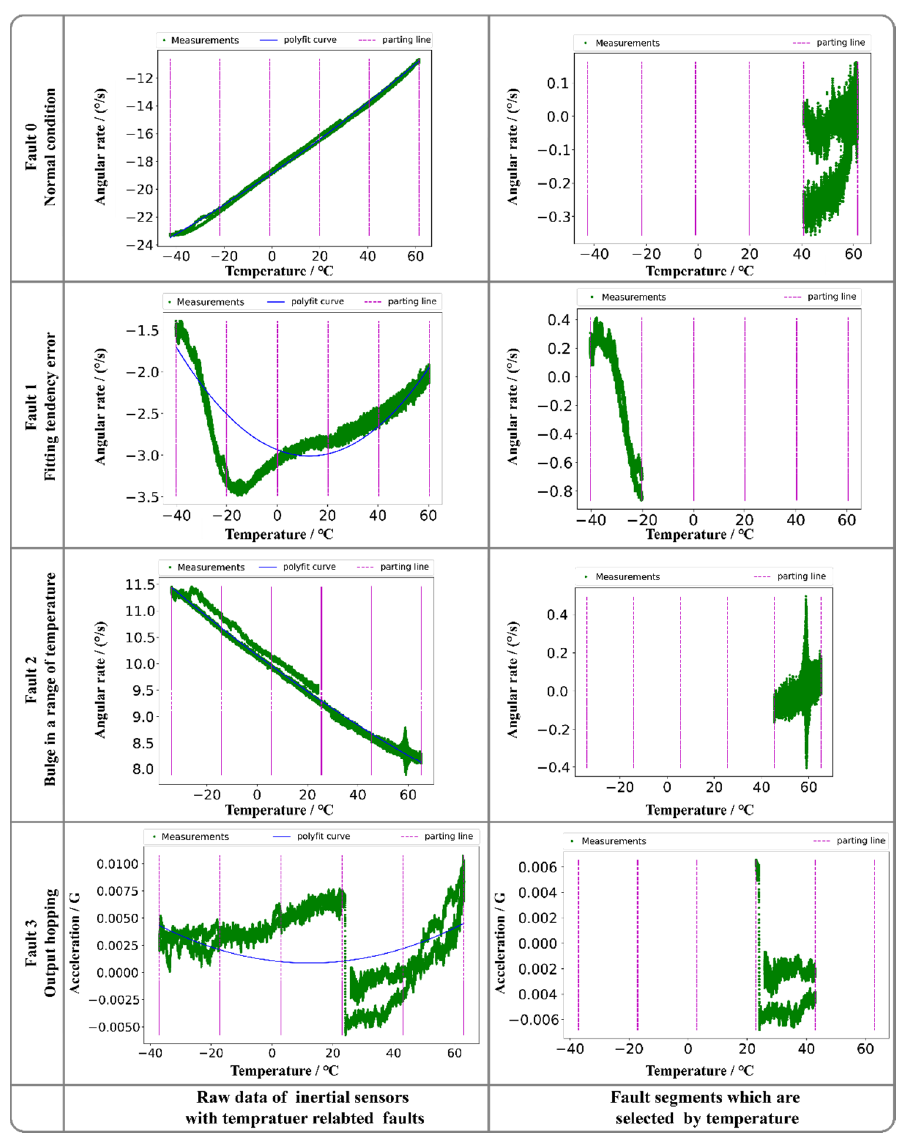
Figure 6. Temperature-related inertial sensors faults.